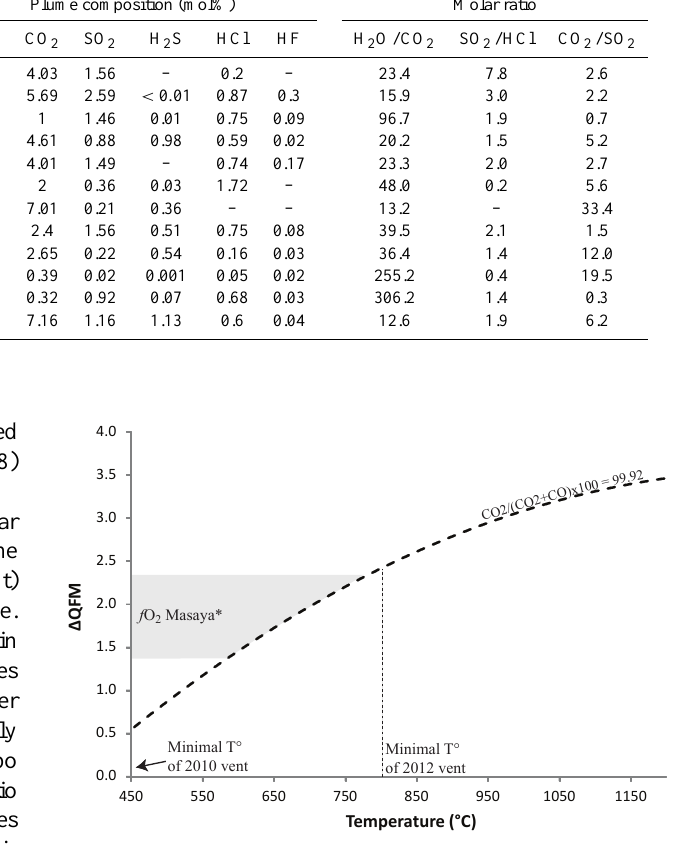
Figure 6. Computed relationship between equilibrium